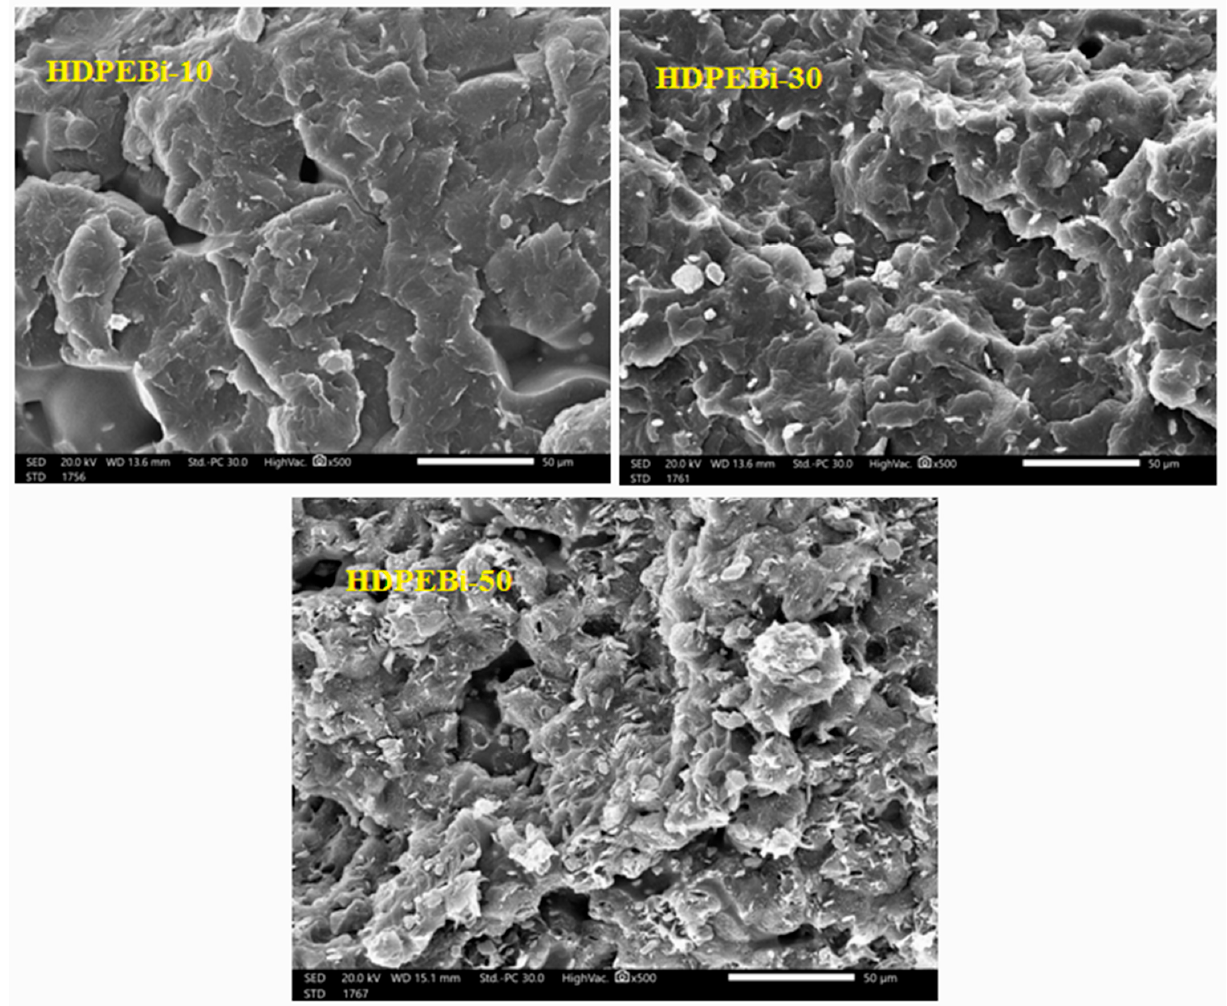
Figure 2. SEM images of different prepared HDPE-Bi 2 O 3 samples. Figure 3. SEM images of different prepared HDPE-Bi 2 O 3